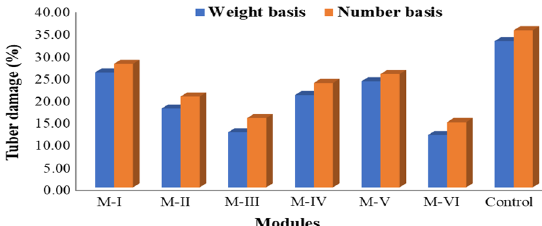
Fig. 2 Effect of different modules on per cent of tuber damage caused by Lepidiota mansueta in potato crop during 2019–2020